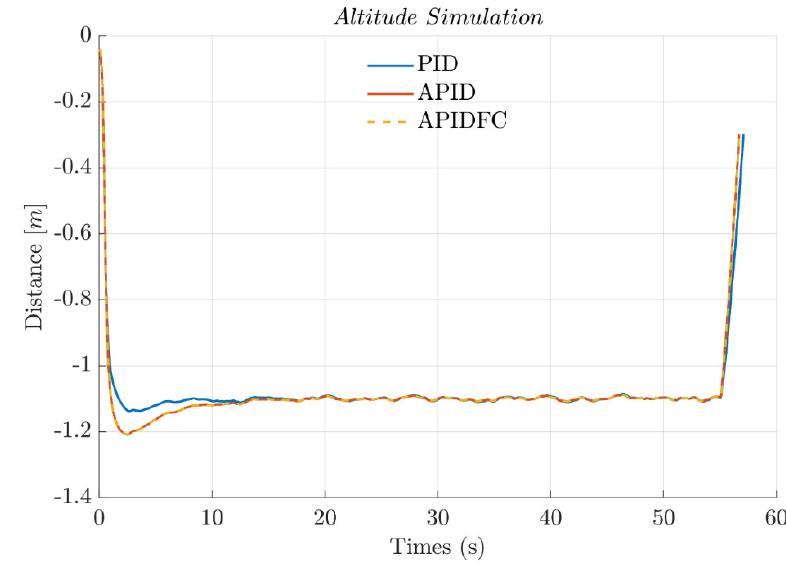
Figure 6. Hovering simulation.